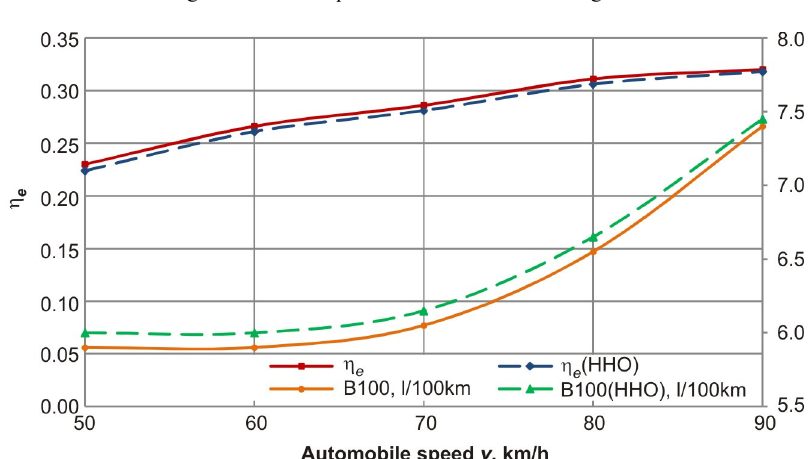
Fig. 7. Engine fuel consumption and net efficiency